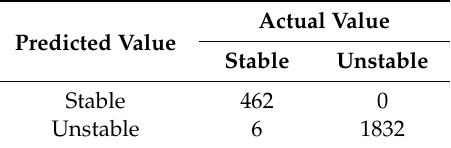
Table 2. Stability prediction results (first 200 cycles).